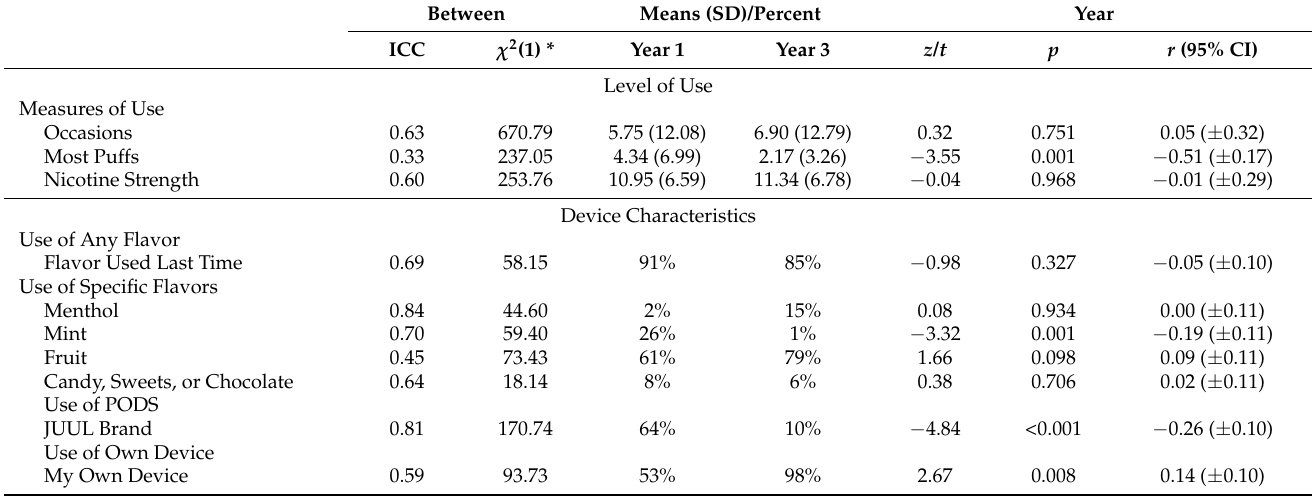
Table 2. Change over time as a function of year, weekday vs. weekend, and their